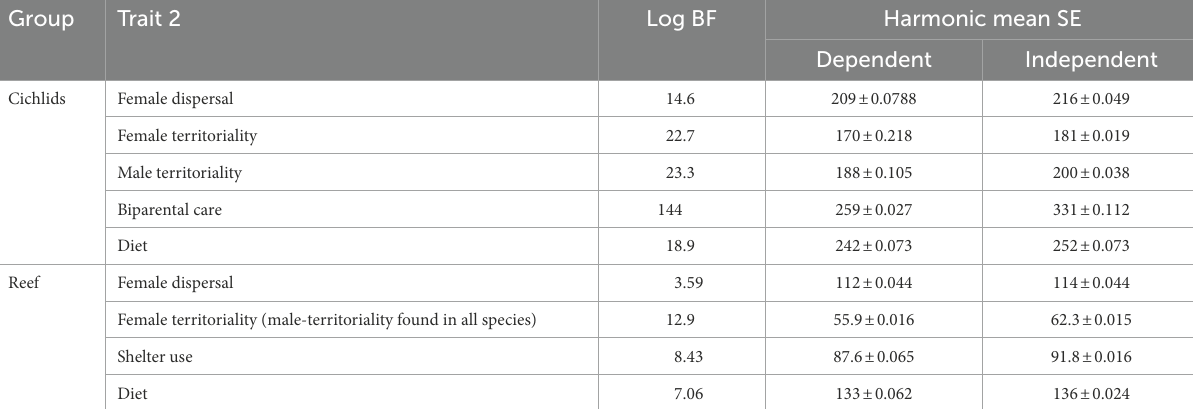
TABLE 1 Summary of the dependent (correlated evolution of the two traits) and independent (independent evolution of the two traits) models of mating system (monogamy) and the presence each of the given traits in cichlids and marine fishes.